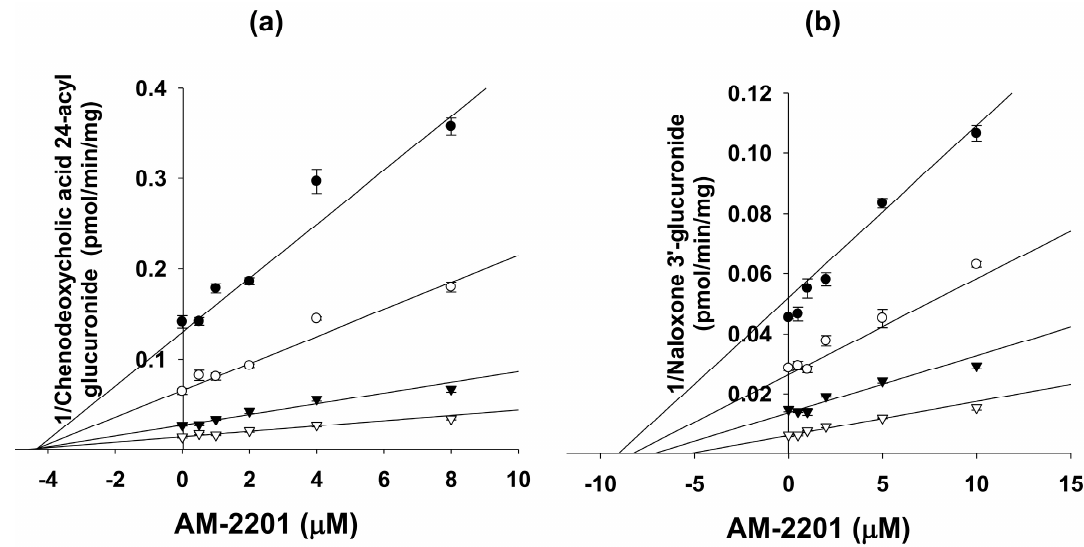
Figure 5. Representative Dixon plots for the inhibitory effects of AM-2201 on ( a ) UGT1A3-catalyzed chenodeoxycholic acid 24-acyl glucuronidation and ( b ) UGT2B7-catalyzed naloxone 3 (cid:48) -glucuronidation in human liver microsomes. Each symbol represents the substrate concentration: ( a ) chenodeoxycholic acid, , 1 µ M, , 2 µ M, (cid:72) , 5 µ M, (cid:53) , 10 µ M; and ( b ) naloxone; , 0.5 µ M; , 1 µ M; (cid:72) , 2 µ M; (cid:53) , 5 µ M. (cid:35) (cid:35) Data represent the mean ± SD ( n =